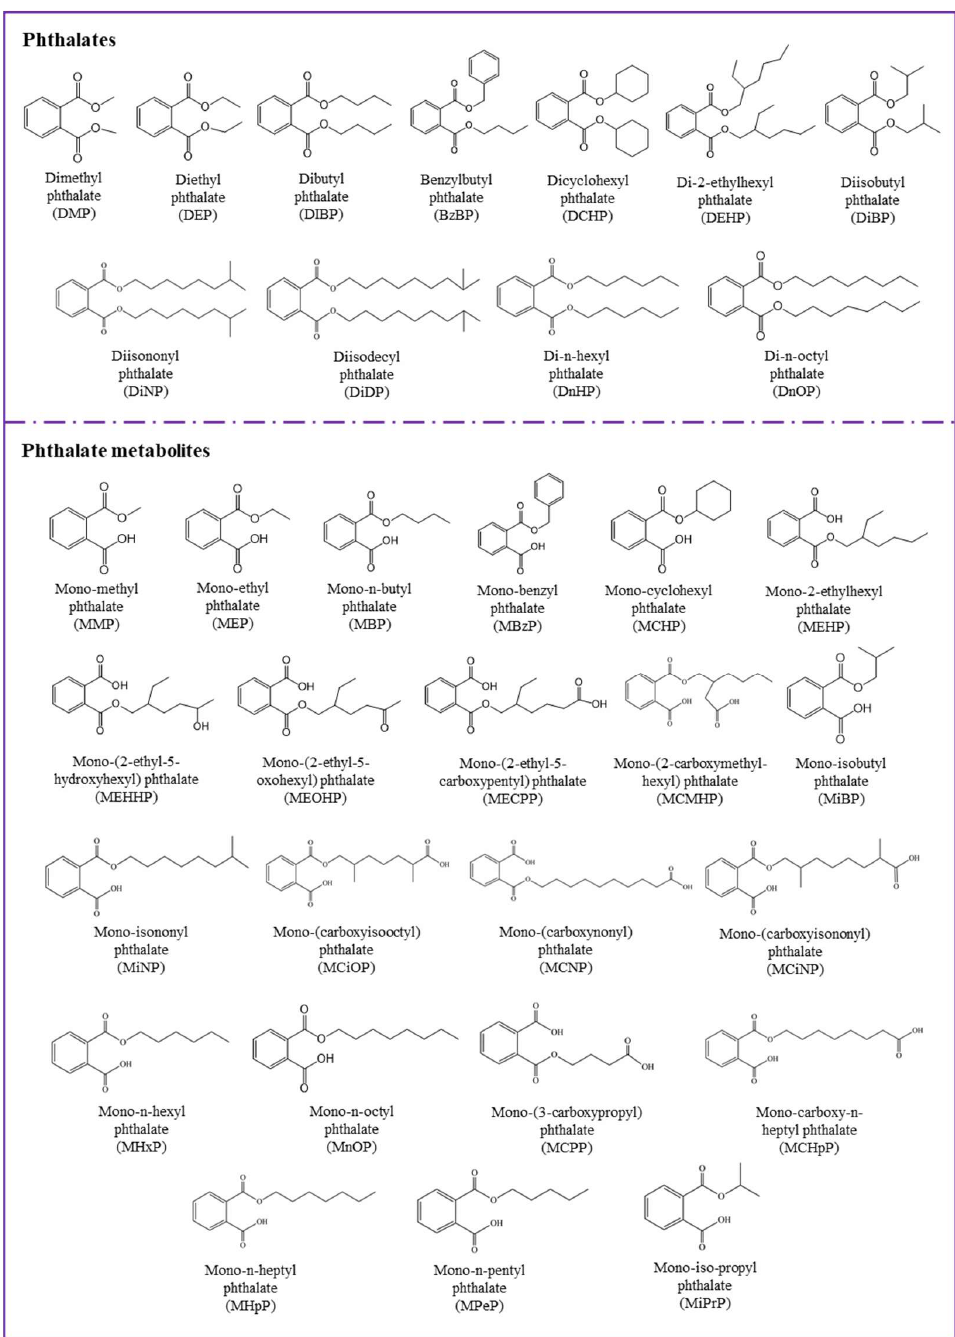
Figure 1. Chemical structures of major phthalates and their metabolites studied in the literature.